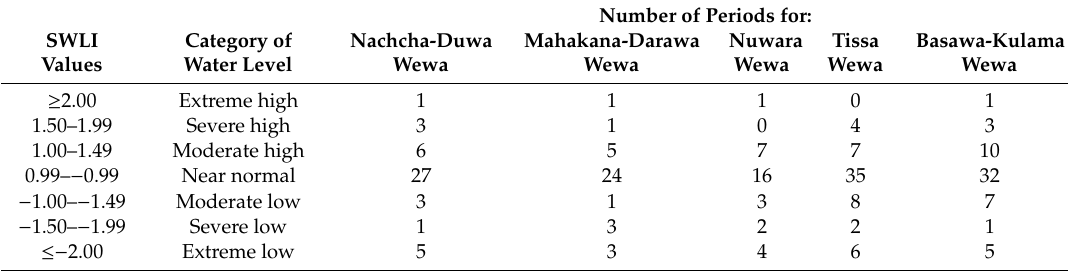
Table 6. Number of high, near normal and low water-level periods for SWLI for each major tank in the headwaters of Aruvi Aru catchment.